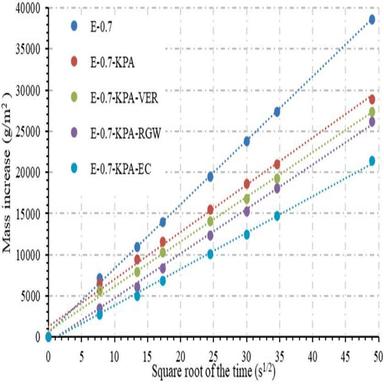
Capillarity absorption test results.